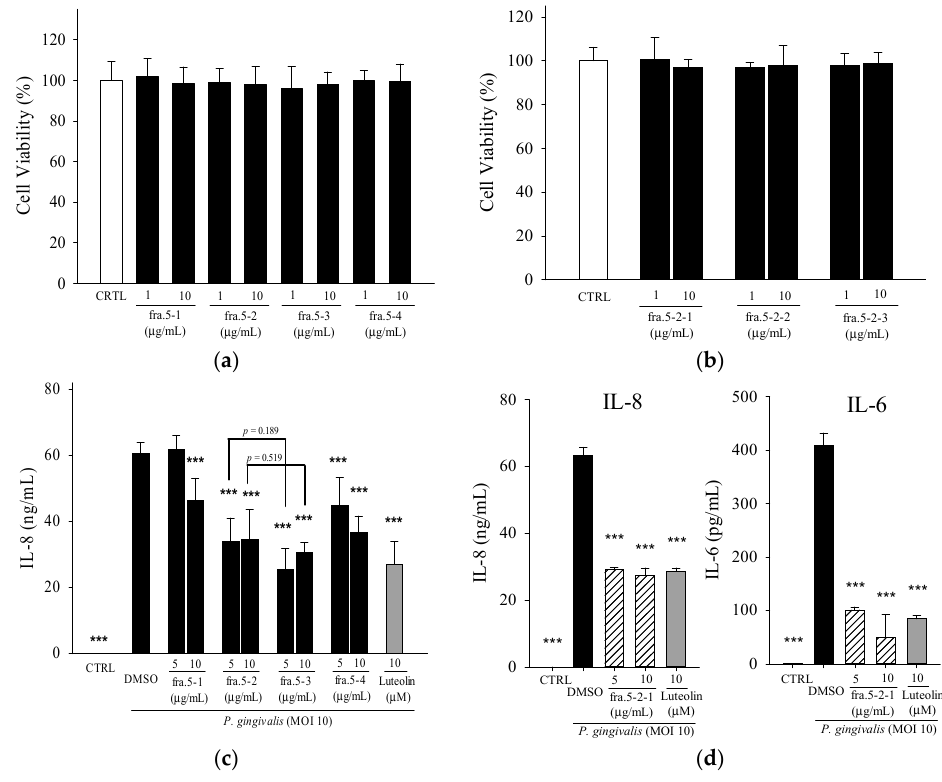
Figure 3. Effects of sub-fractions obtained from the active fraction, Fraction 5, on P. gingivalis -induced cytokines in THP cells. ( a , b ) Cell viability was determined by MTT assay; ( c , d ) IL-8 or IL-6 level was determined in THP-1 cells co-incubated with P. gingivalis (M.O.I. = 10) and the indicated concentrations of samples for 24 h. Luteolin was a positive control. A control experiment (CTRL) without P. gingivalis treatment was conducted in parallel. Each column shows the mean ± SD of three independent experiments, each done in quadruplicate. *** p < 0.001 vs. DMSO vehicle ( P. gingivalis alone).